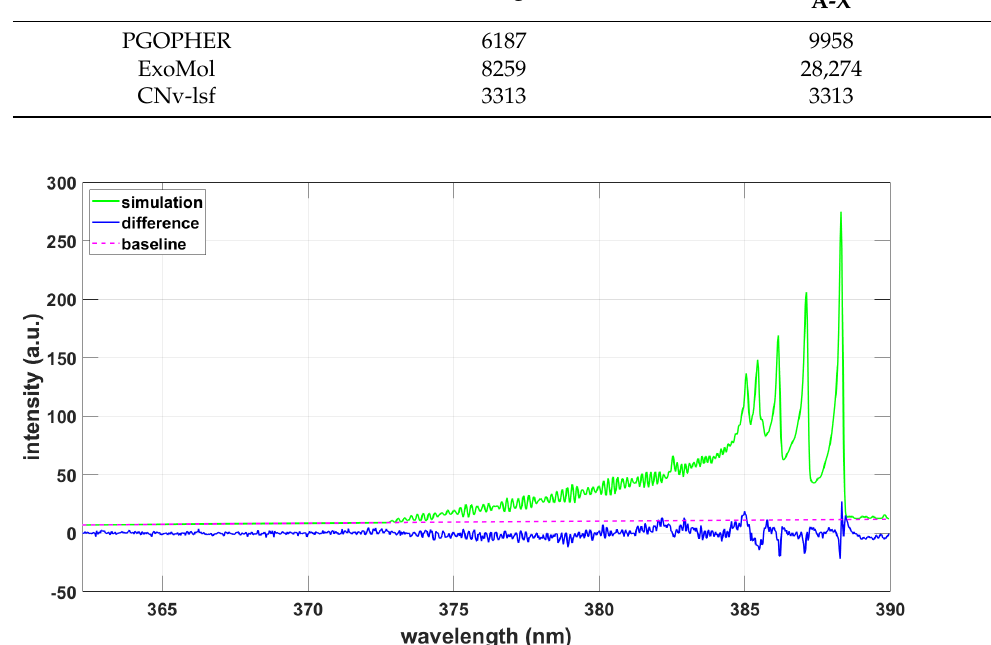
Figure 9. Simulation using CNv-lsf data and the NMT program, T = 8940 K, ∆ λ = 0.11 nm.